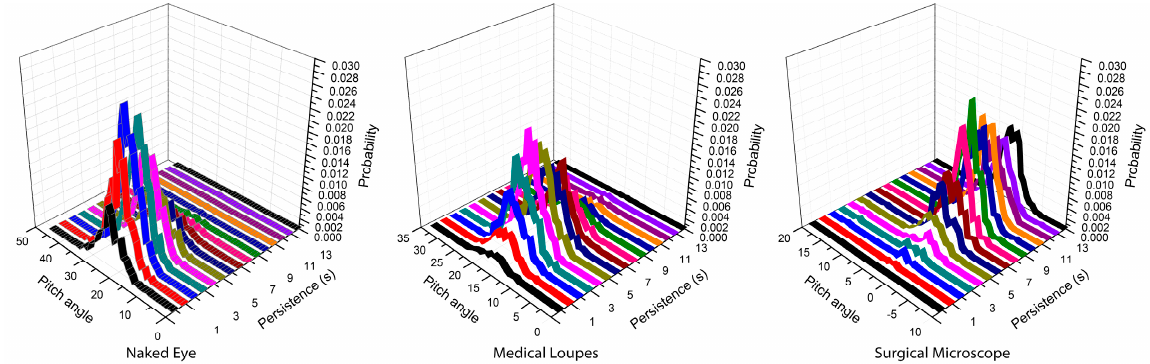
Figure 13. Analysis of static posture persistence of the neck pitch angle for naked eye, medical loupes and surgical microscope. The “persistence” represents the length of time the same pitch angle of the neck is kept during interventions. Each graph represents a normalized two-dimensional histogram of the occurrences; the vertical axis can then be assumed as the probability that a specific pitch angle is kept for a specific length of time.